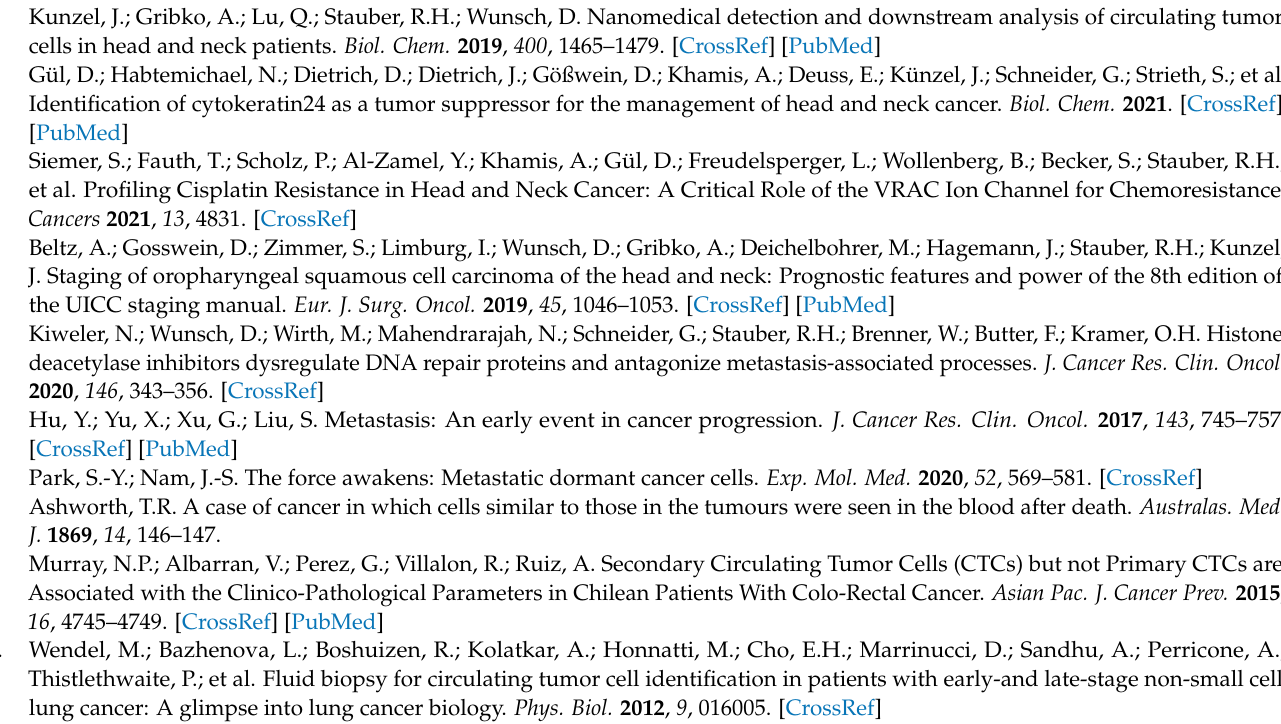
Figure S6: Establishment of CTCelect unit improves purity of isolated tumor cells from whole blood; Table S1: Detailed protocol of IsoMAG isolation